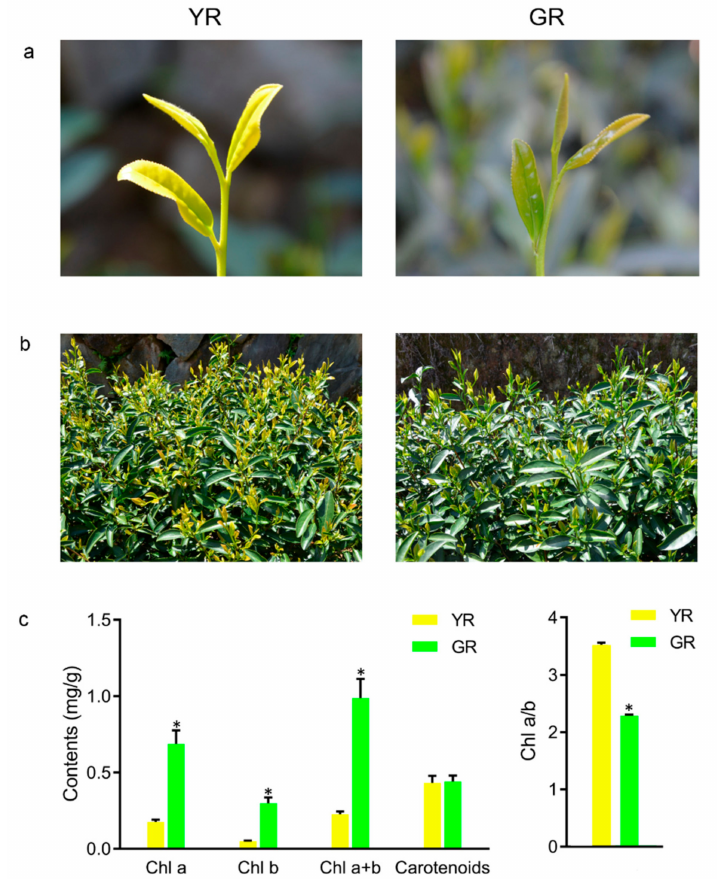
Figure 1. Phenotype and pigment contents of green-leaf cultivar Rougui (GR) and its yellow-leaf mutant (YR). ( a ) Leaf color changes between yellow-leaf mutant YR and its original cultivar GR. ( b ) Performance of YR and GR in the field. ( c ) Chl a, Chl b, Chl a + b, and total carotenoid contents and the Chl a / b ratio of young shoots with one bud and two leaves from YR and GR. Error bars indicate the standard error of the mean ( n = 3). Student’s t test was employed and asterisks indicate significant di ff erences between YR and GR ( p <